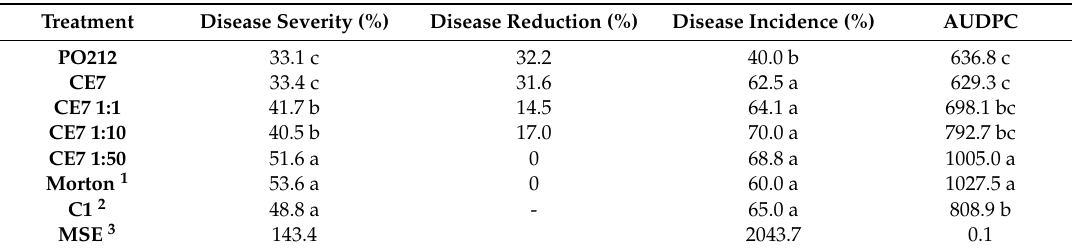
Table 4. Evaluation of optimal concentration for CE7 (crude extract after growing into Morton’s medium for 7 days) application.